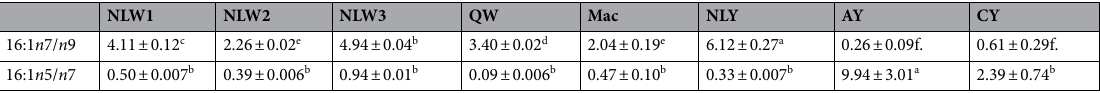
Table 2. Lipid composition (nanomole percent ± standard error) observed in white and golden variants of Newfoundland chanterelles. Values (nanomole percent by weight composition) represent means ± standard errors for four replicates. ND not detected, SFA saturated fatty acids, MUFA monounsaturated fatty acids, PUFA polyunsaturated fatty acids, n position position of the first double bond counted from methyl end group of unsaturated fatty acid. Sample codes AY: Cantharellus betularum (golden); CY: C. camphoratus (golden); Mac: average of Mac1–Mac5 from a mixture of golden and white NL chanterelles; NLW1–3: C. enelensis (Newfoundland, white 1–3); NLY: C. enelensis (Newfoundland, golden); QW: C. enelensis (Québec, white). Lipid acronyms: Cer ceramide, CmE campesterol ester, DG diacylglycerol, HexCer